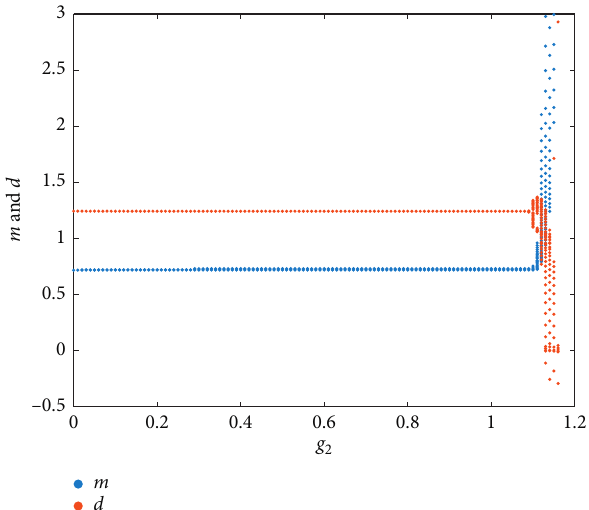
Figure 7: The effect of the adjustment coefficient on the leadership self-leadership coefficient and relational leadership